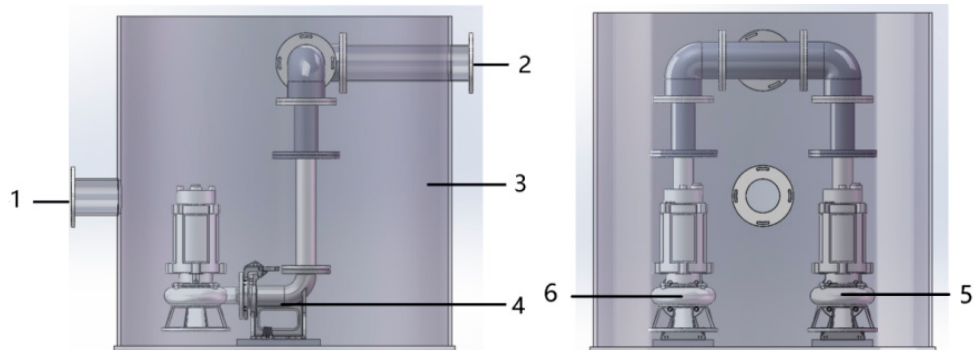
Figure 1. General assembly drawing of three-dimensional model of centrifugal prefabricated pump- ing station. 1. Inlet; 2. outlet; 3. round prefabricated barrels; 4. couplers; 5. submersible centrifugal pump 1; 6. submersible centrifugal pump 2.